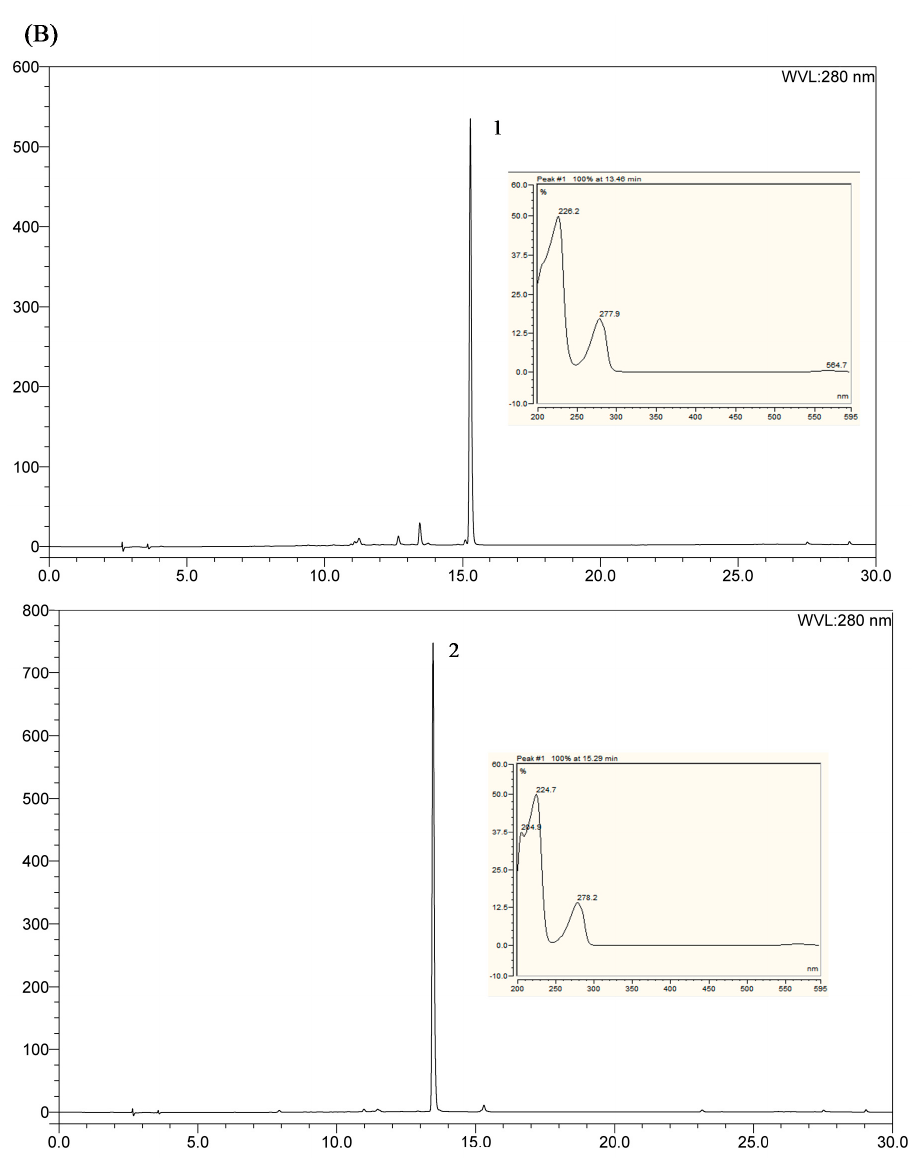
Figure 4 . Chromatograms of HPLC of the DRF ( A ) and collected compounds ( B ) from HSCCC. Experimental condition of HPLC: a Capcell Pak C-18 column (150 mm × 4.6 mm, I.D., 5 μ m,